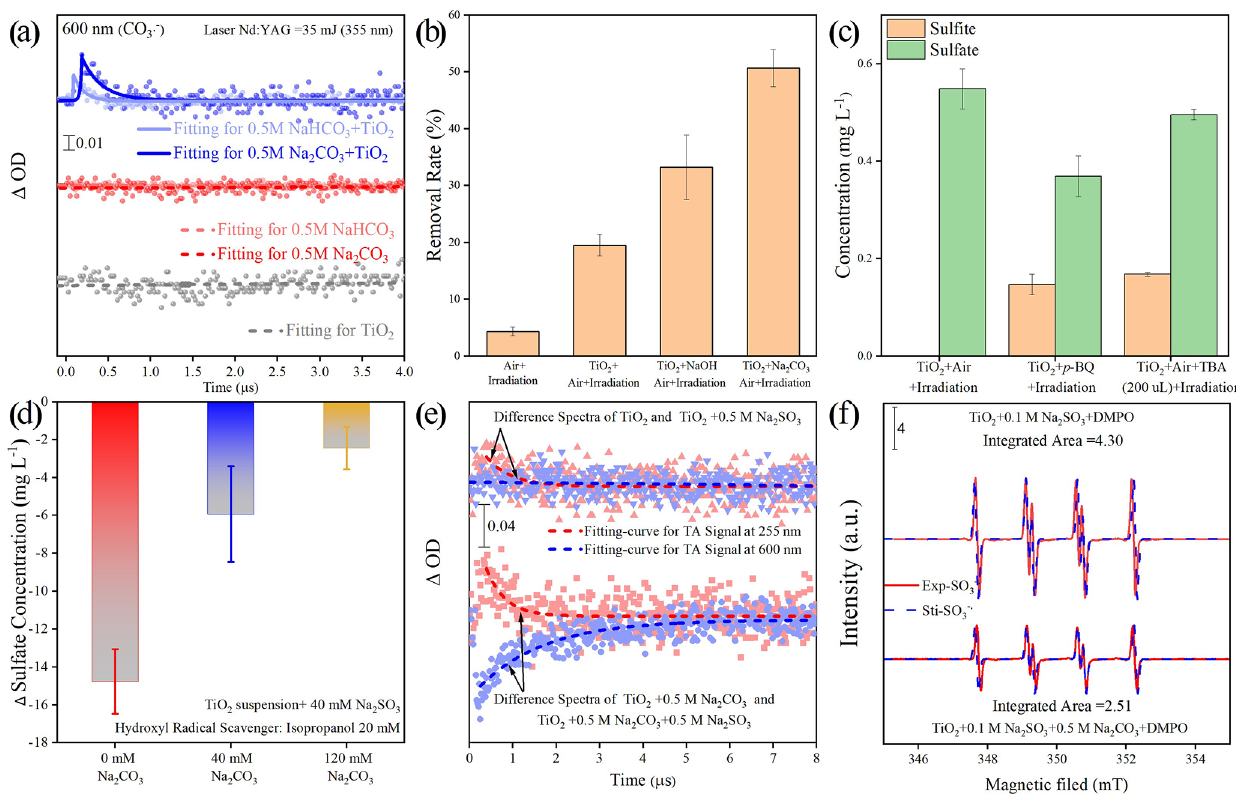
Figure 7. (a) Single-wavelength transient absorption spectra of various aqueous solutions. (b) The removal rate of aniline after exposure to airflow under irradiation in the absence and presence of mineral dust particles for 300s. Reaction conditions are RH of 30%, light intensity ( I ) of 30mWcm − 2 , and a total flow rate of 52.5mLmin − 1 . Note that an adequate amount of NaOH was introduced into the TiO 2 suspension system to achieve a pH environment condition identical to that of the TiO 2 + Na 2 CO 3 suspension system. (c) Determination of sulfite and sulfate concentration after exposure to air flow under irradiation in the absence and presence of mineral dust particles for 20min. Reaction conditions are RH of 30%, light intensity ( I ) of 30mWcm − 2 , and a total flow rate of 52.5mLmin − 1 . (d) Sulfate formation change (cid:49) (SO 2 − ) is determined by different sulfate concentrations with and without the addition of isopropanol as hydroxyl radical scavenger. (e) The 4 difference in transient absorption kinetics of the sulfite radical and carbonate radical at the various aqueous solutions and their corresponding growth–decay fit curves. A (cid:49)A signal was recorded at 255 and 600nm after a pulsed 355nm laser excitation. (f) Electron spin resonance (cid:113) − (ESR) spectrometry of [DMPO–SO ] intermediary formed in a solution of TiO 2 (3mg per 4mL) + 0.1M Na 2 SO 3 and TiO 2 (3mg per 3 4mL) + 0.5M Na 2 CO 3 + 0.1M Na 2 SO 3 . For clarity, the integrated areas of the ESR profiles were also presented for direct comparison. Note that Exp. and Sti. stand for experimental results and corresponding fitting results using isotropic radicals software.